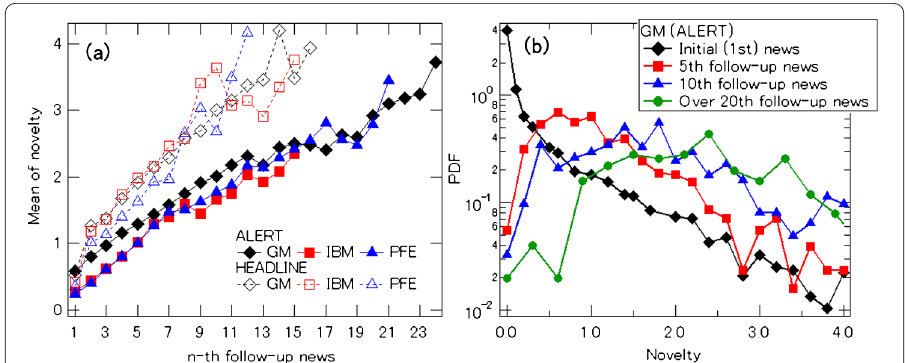
Figure 4 Novelty of follow-up news articles for GM, IBM, and PFE. ( a ) Mean of novelty. ( b ) PDF of novelty for the 1st, 5th, 10th, and more than 20th follow-up ALERT news articles for GM.